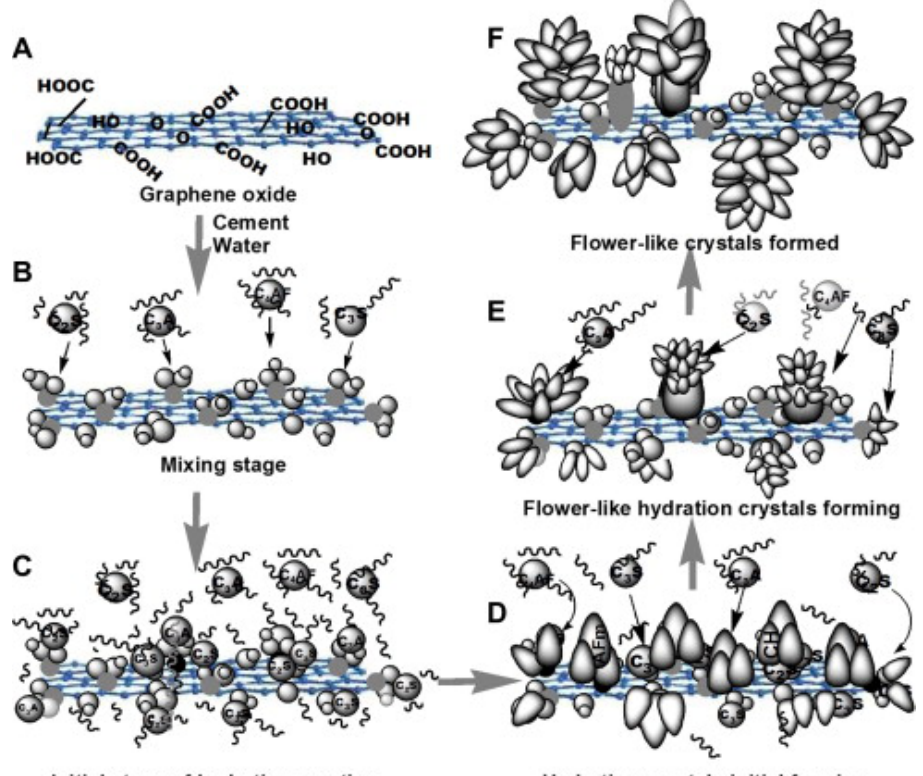
Figure 4: Schematic diagram of regulation mechanism of GO on cement hydration crystals [71]